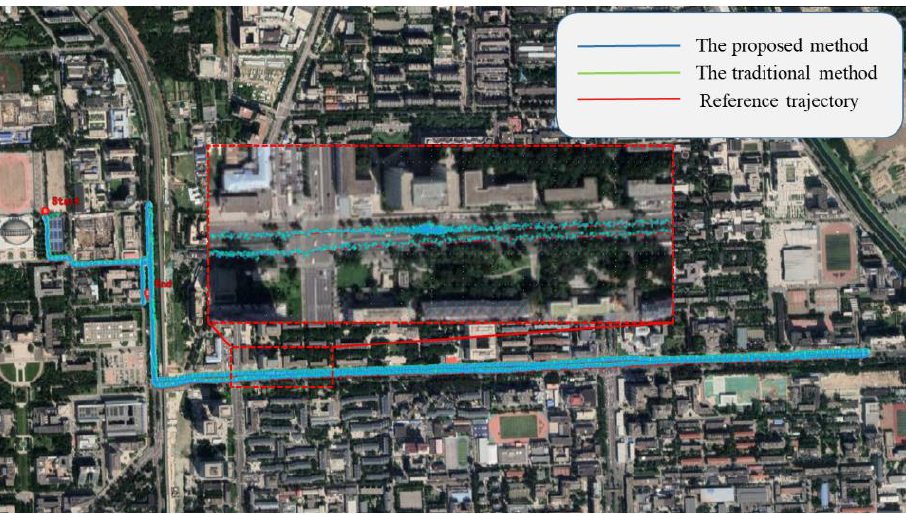
Figure 6. Kinematic test positioning results in an open-sky area.